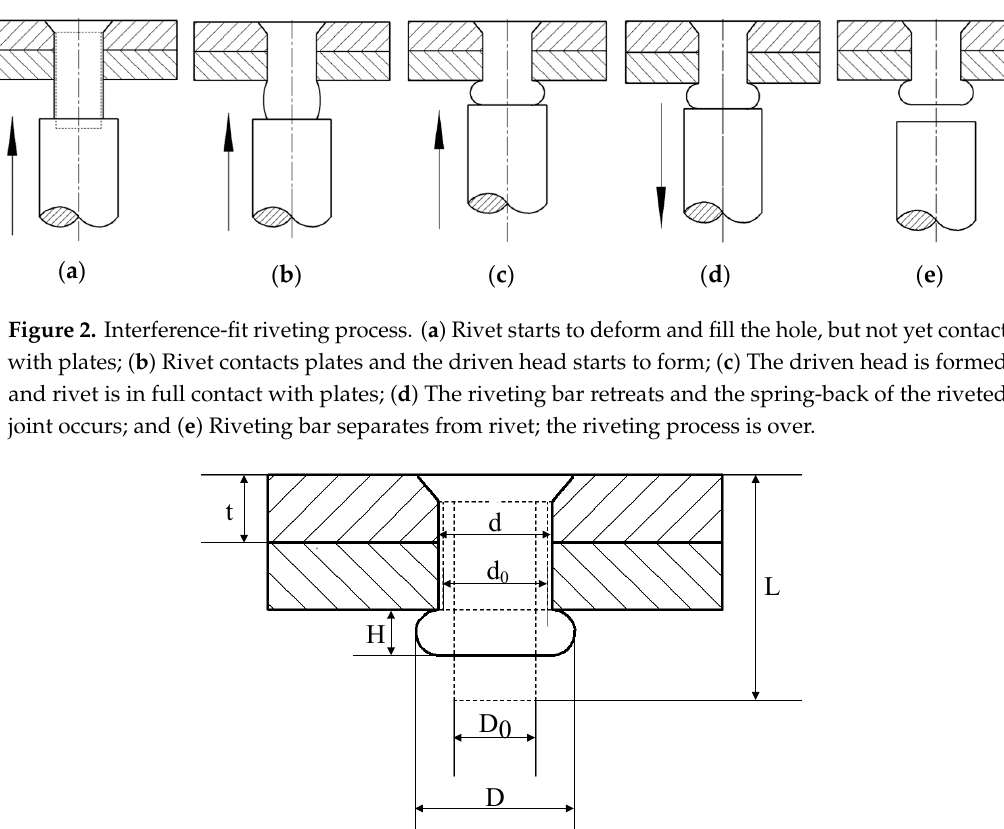
Figure 3. The final shape of the riveted joints. t : Plate thickness; d 0 : Rivet hole diameter before riveting; d : Rivet hole diameter after riveting; D 0 : Rivet diameter; L : Rivet length; D : Driven head diameter; H : Driven head height.